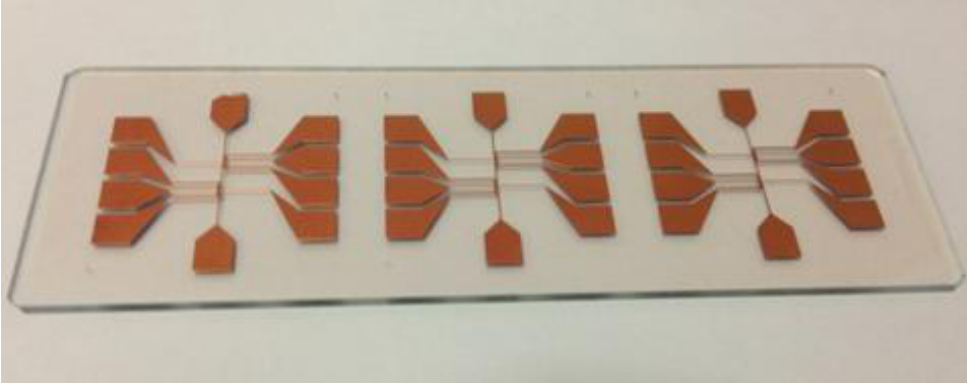
Figure 3. Photograph of three fabricated signal layer transparent atom